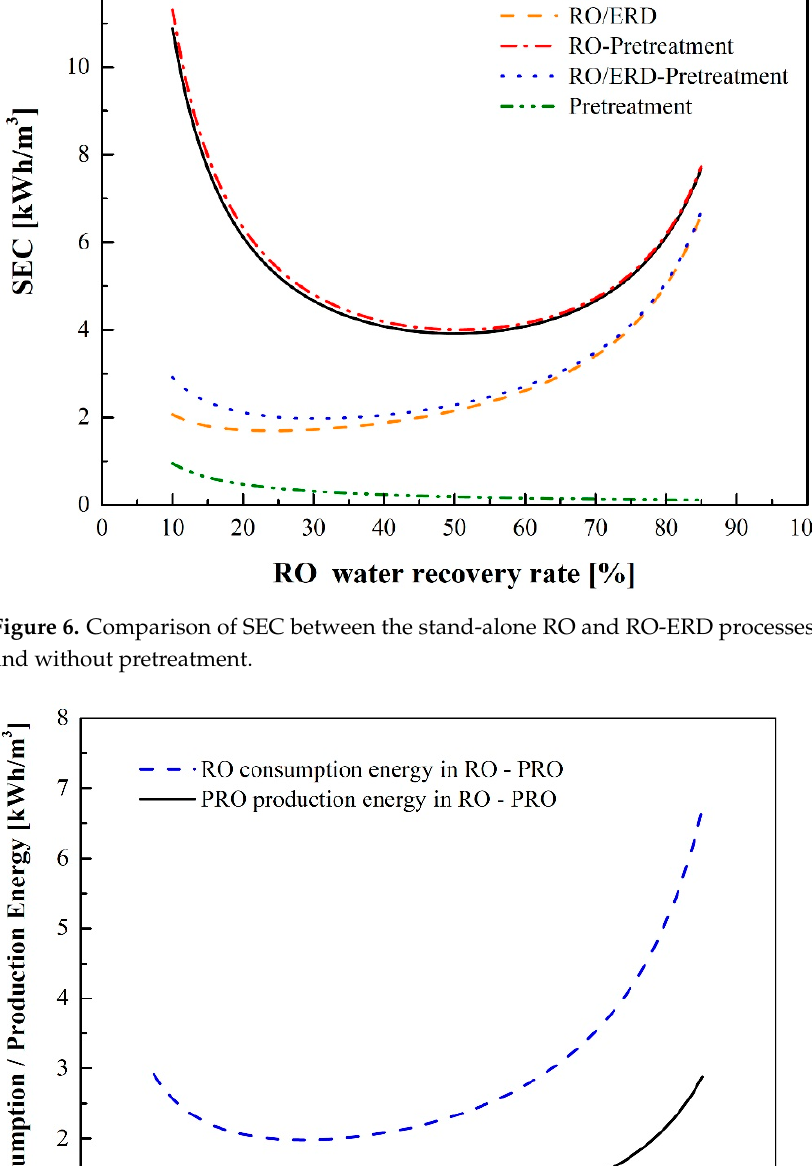
Table 1. The parameters used in stand-alone RO and/or RO-ERD process simulations.